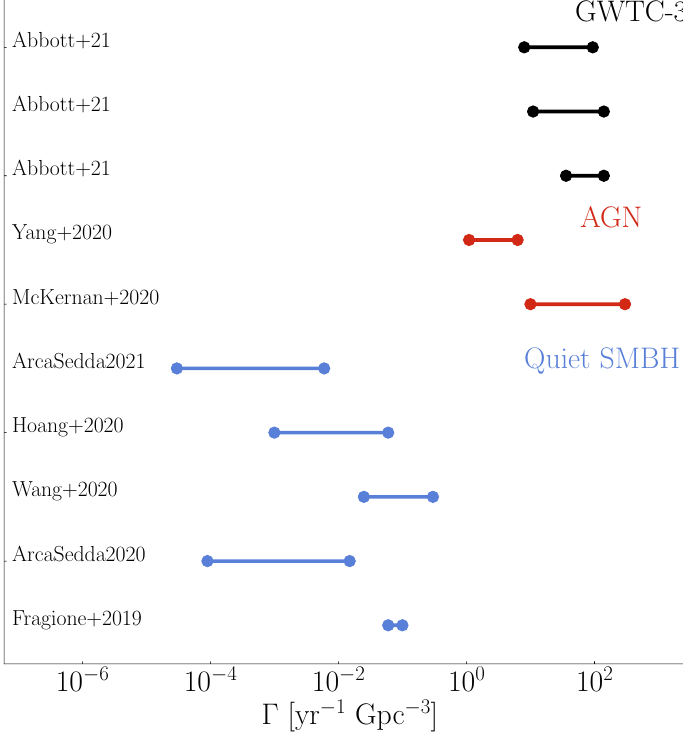
Figure 15. Same as in Figure 14, but for NS–BH